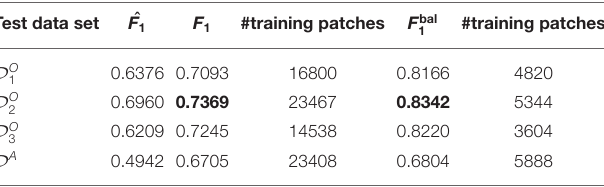
TABLE 5 | The results of the leave-one-set-out inter-set study (Experiment C): ˆ F 1 and F 1 scores obtained from training a ResNet-34 on three of the four data sets and testing it on the data set that was excluded from the training set.